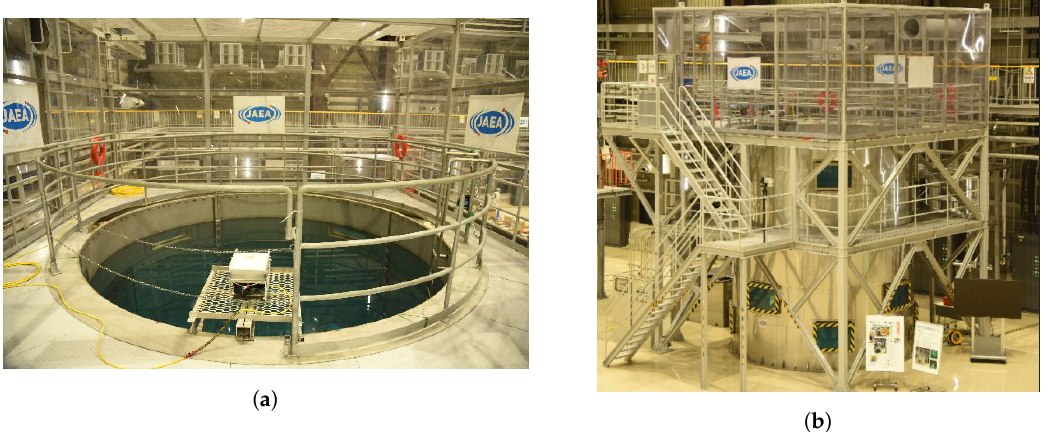
Figure 1. View of the access to the robot test pool can be seen in ( a ), and overall view of the robot